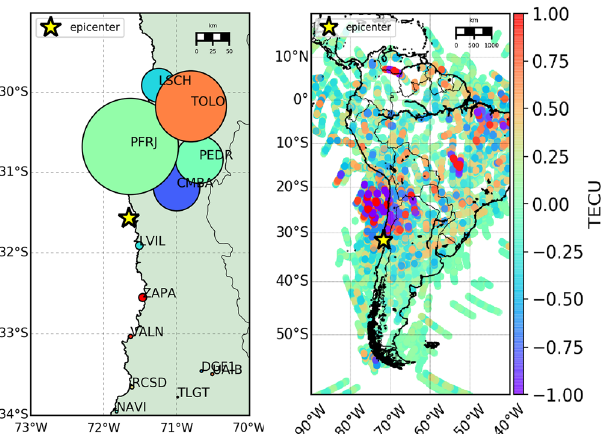
Figure 4. Left panel—Map of the earthquake ground shaking: the dimension of the station markers is proportional to the energy associated to the Up component of the earthquake ground shaking for some stations near the epicenter. It is evident that north placed stations are characterized by a higher energy than south placed ones. Right panel—Space-time sTEC variations at the SIPs for less than two hours (22:54:49-23:59:59 GPS time) th on 16 September 2015 for all the satellites in view (cut-off angle set to 20